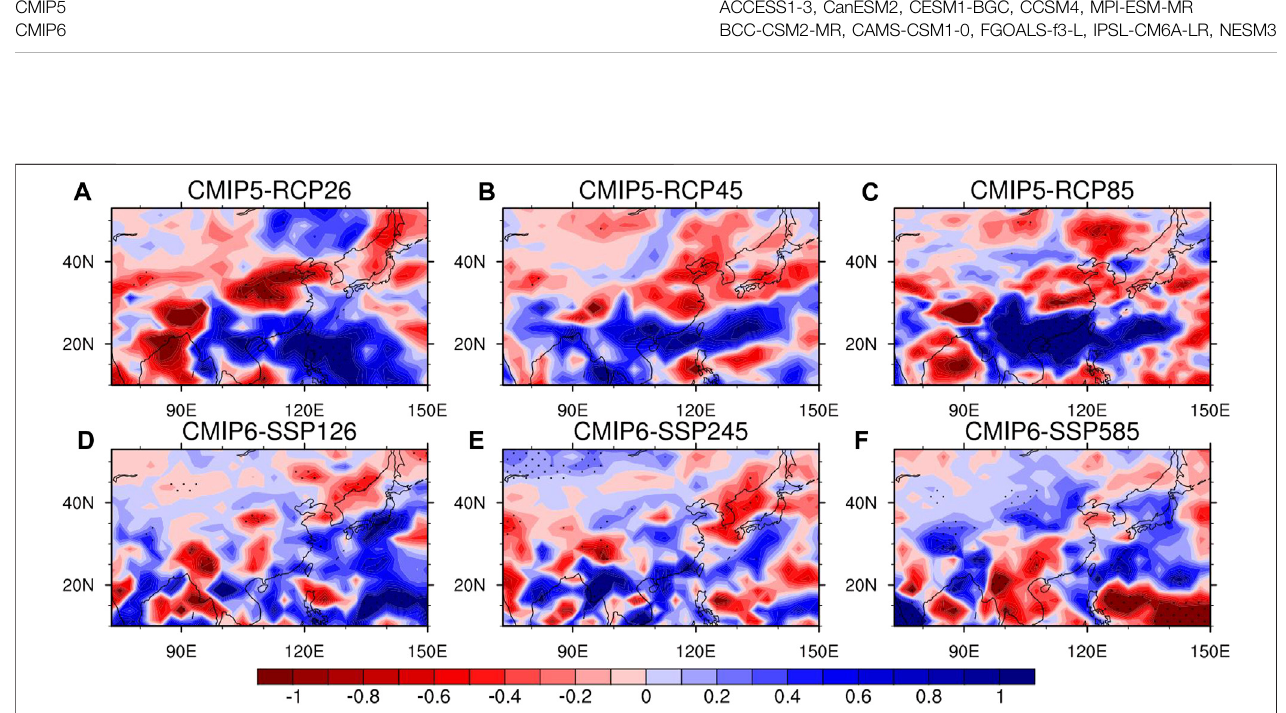
Frontiers in Earth Science |